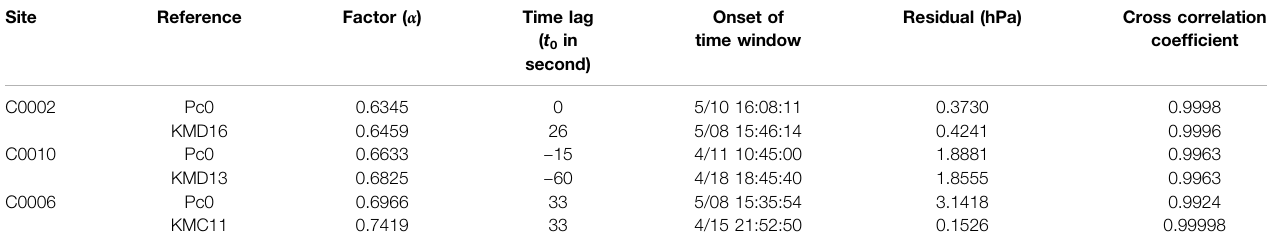
TABLE 1 | Estimated parameters for estimation of pore pressure at Pc1.